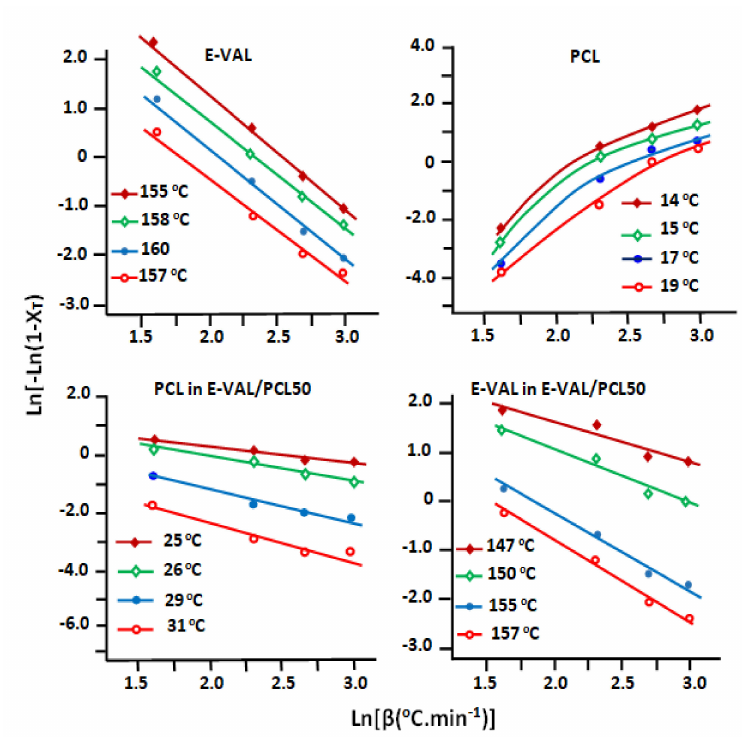
Figure 12. Ozawa plots indicating the variation of ln[ − Ln(1 − X t ) vs. Ln( β ) for pure E-VAL and the E-VAL/PCL blend containing 75 wt%